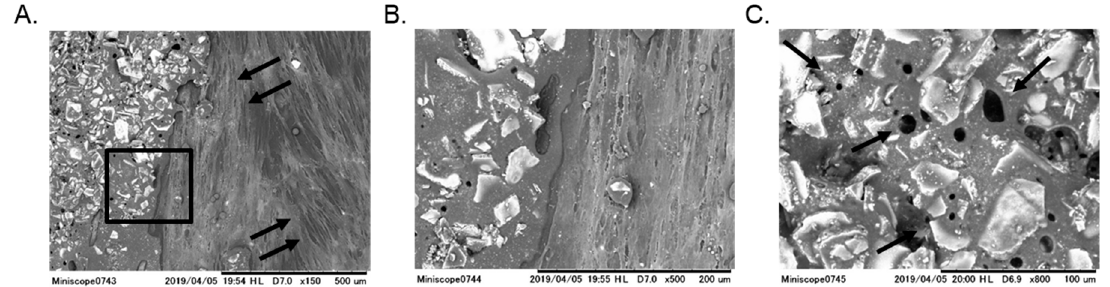
Figure 2. Co-culturing with human dental pulp stem cells (hDPSCs). Representative image of hDPSCs with NPC (50:50) for 7 days ( A – C ).